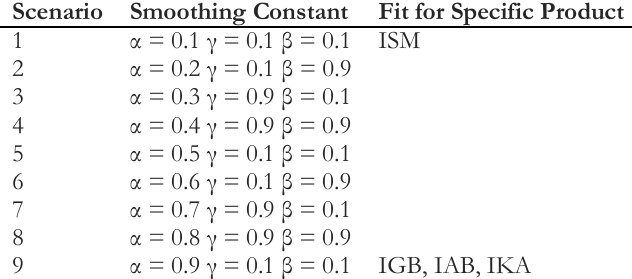
Fig. 6. Seasonal pattern and trend analysis for IKA. Table 2. Smoothing constant scenarios.